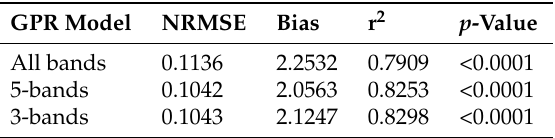
Table 8. Summary of the cross validation. The results show the mean values of the NRMSE, Bias, r 2 and p -value by using the GPR model with all bands, 5-bands and 3-band models for 500